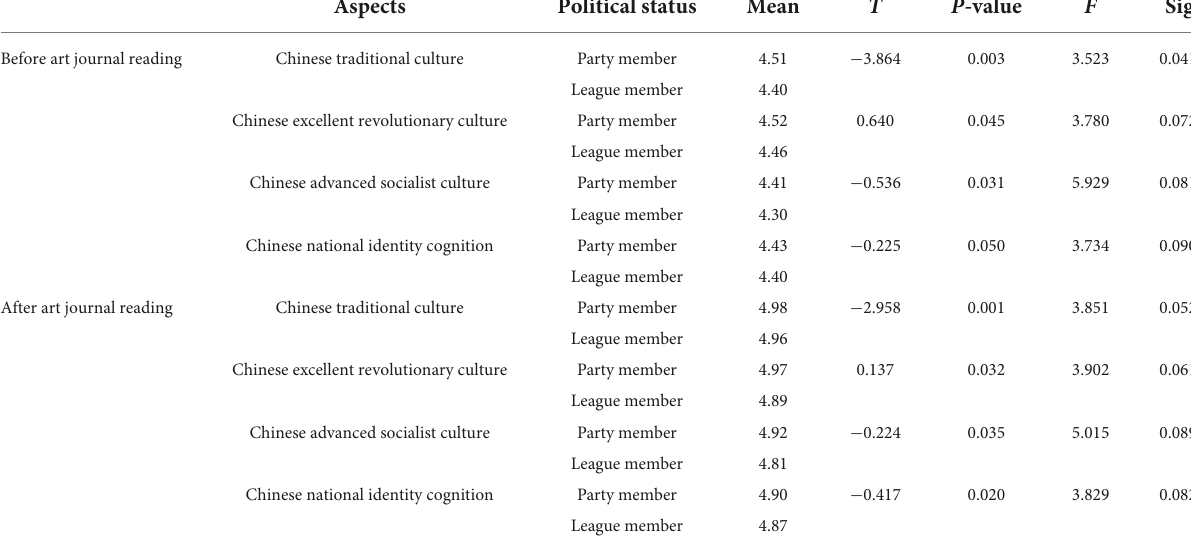
TABLE 7 Comparison of the national cognition and cultural acceptance of college students with the different political status. Aspects Political status Mean T P -value F